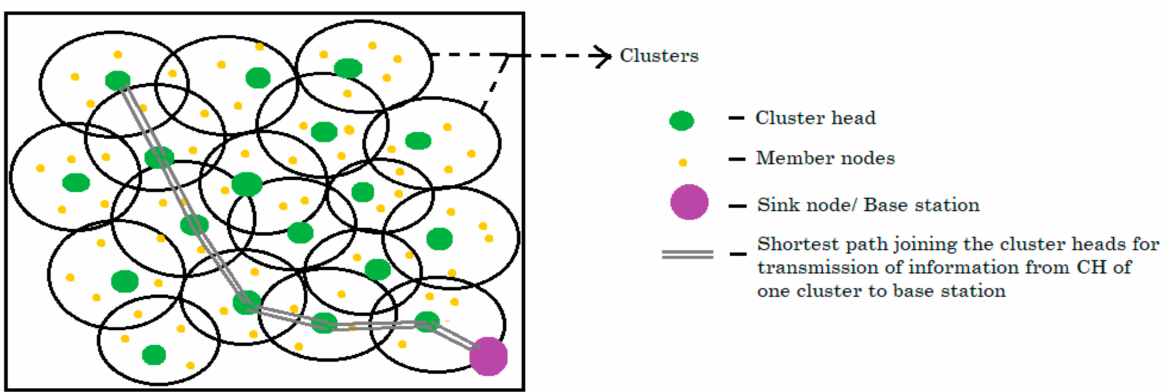
Figure 6. Cluster formation and optimal routing. CH: cluster